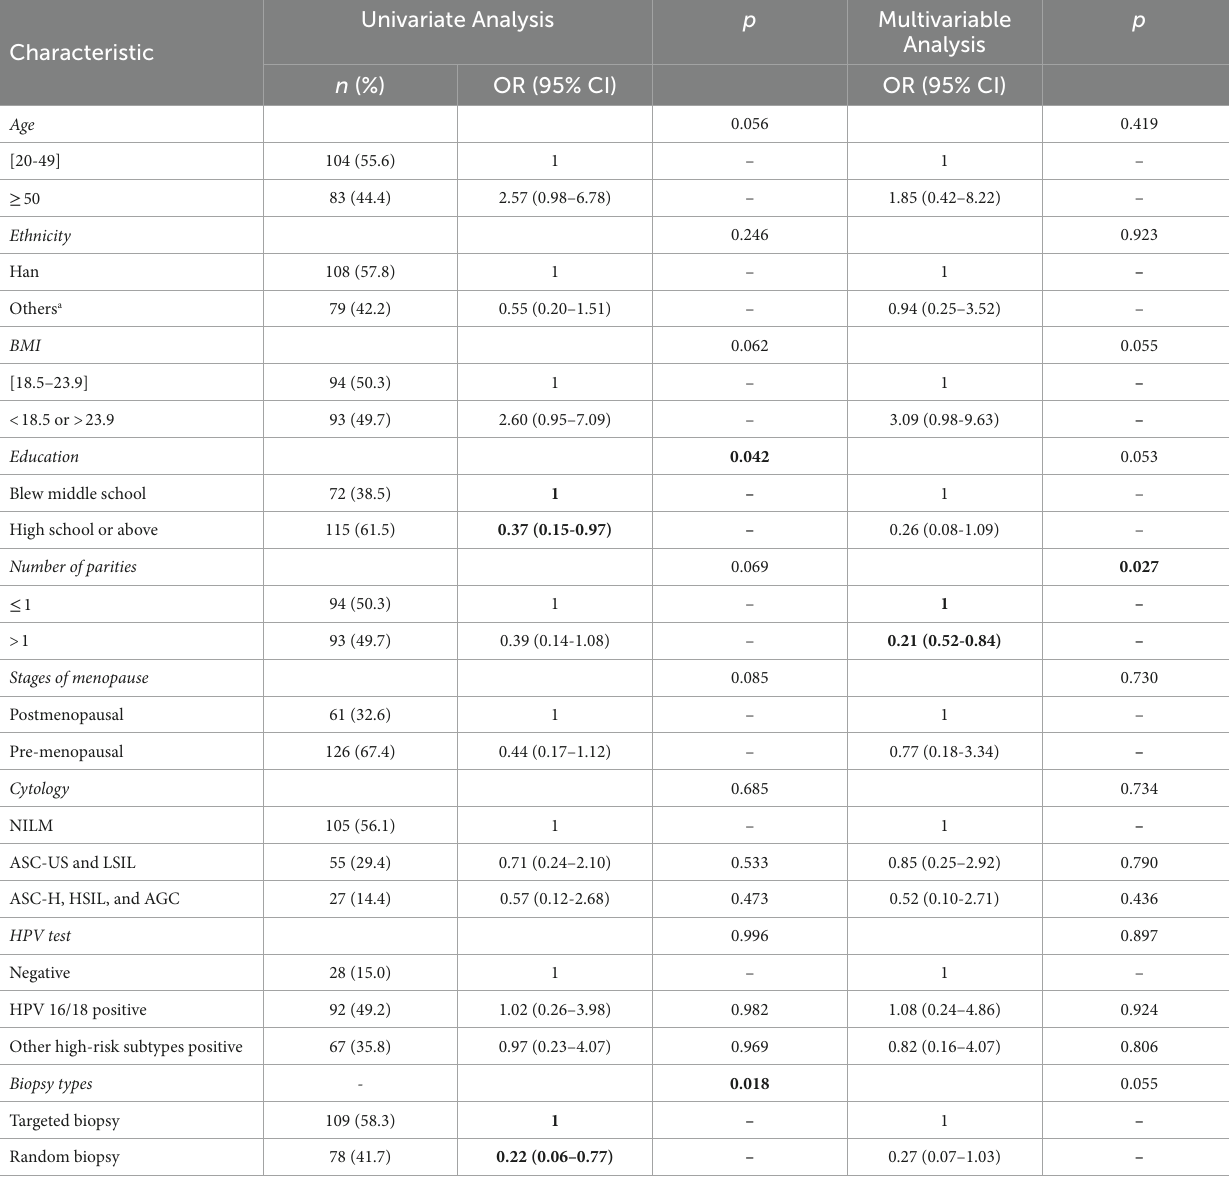
TABLE 4 Logistic regression analysis of the demographic and clinical characteristics affecting CAIADS-related underdiagnosis in detecting cervical diseases.